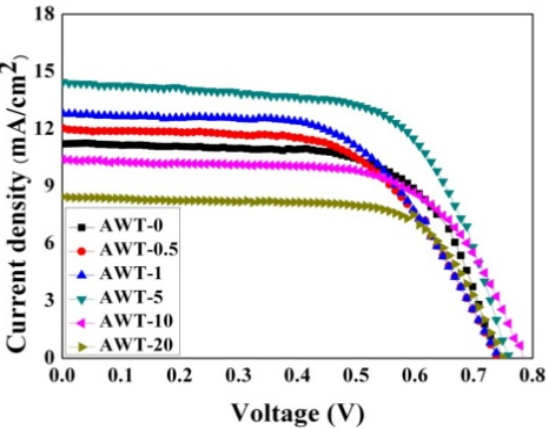
Figure 4. I-V curves of cells based on AWT-0, AWT-0.5, AWT-1, AWT-5, AWT-10, and AWT-20 composite films electrodes. Table 1. Performance parameter characteristics of DSSCs based on different AWT/P25 photoanode films.